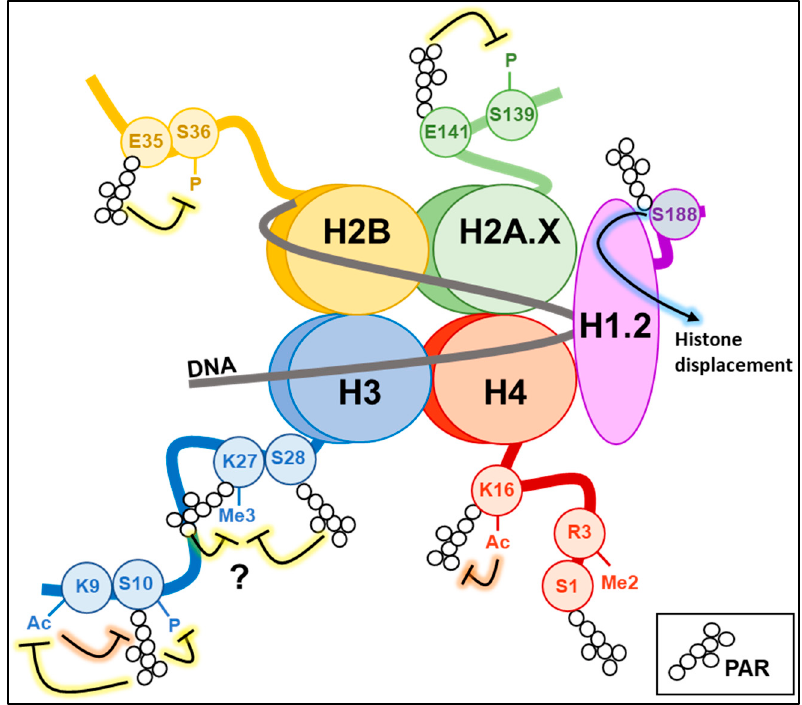
Figure 2. Histone PARylation code. The picture shows the PARylation of amino acid residues identified in vivo or in vitro on histone tails and their relative effects (known or hypothesised) on other histone epigenetic marks. Ac: acetylation; Me3: trimethylation; P: phosphorylation.